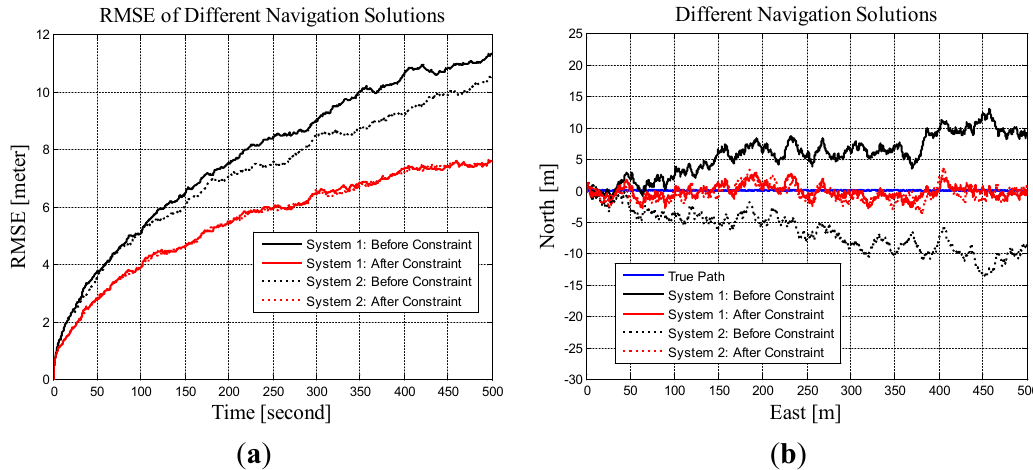
Figure 1. ( a ) RMSE (Root-Mean-Square Error) versus time; ( b ) Trajectories of one simulation.